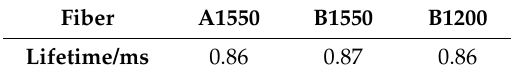
Figure 8. Fluorescence lifetime decays of fibers derived from the sol-gel granulated silica method (log scale). The fluorescence decays of the fibers are separated by 1 ms for clarity. Table 5. Fluorescence lifetime of fibers derived from the sol-gel granulated silica